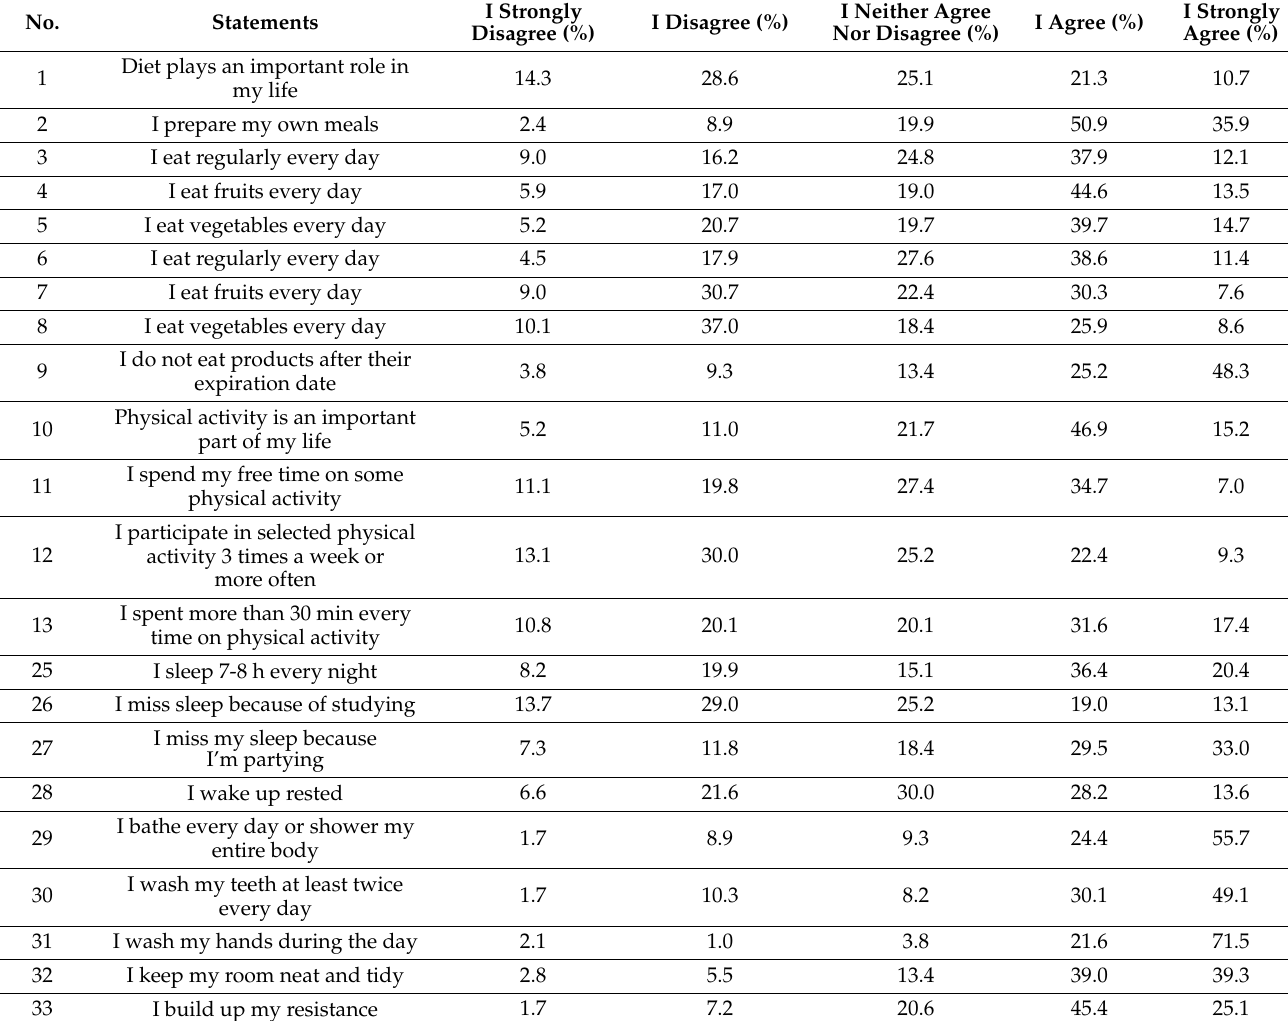
Table 5. Behaviour mainly related to physical health: taking care of the body and its immediate surroundings, physical activity, rational nutrition, sleep of an appropriate duration and